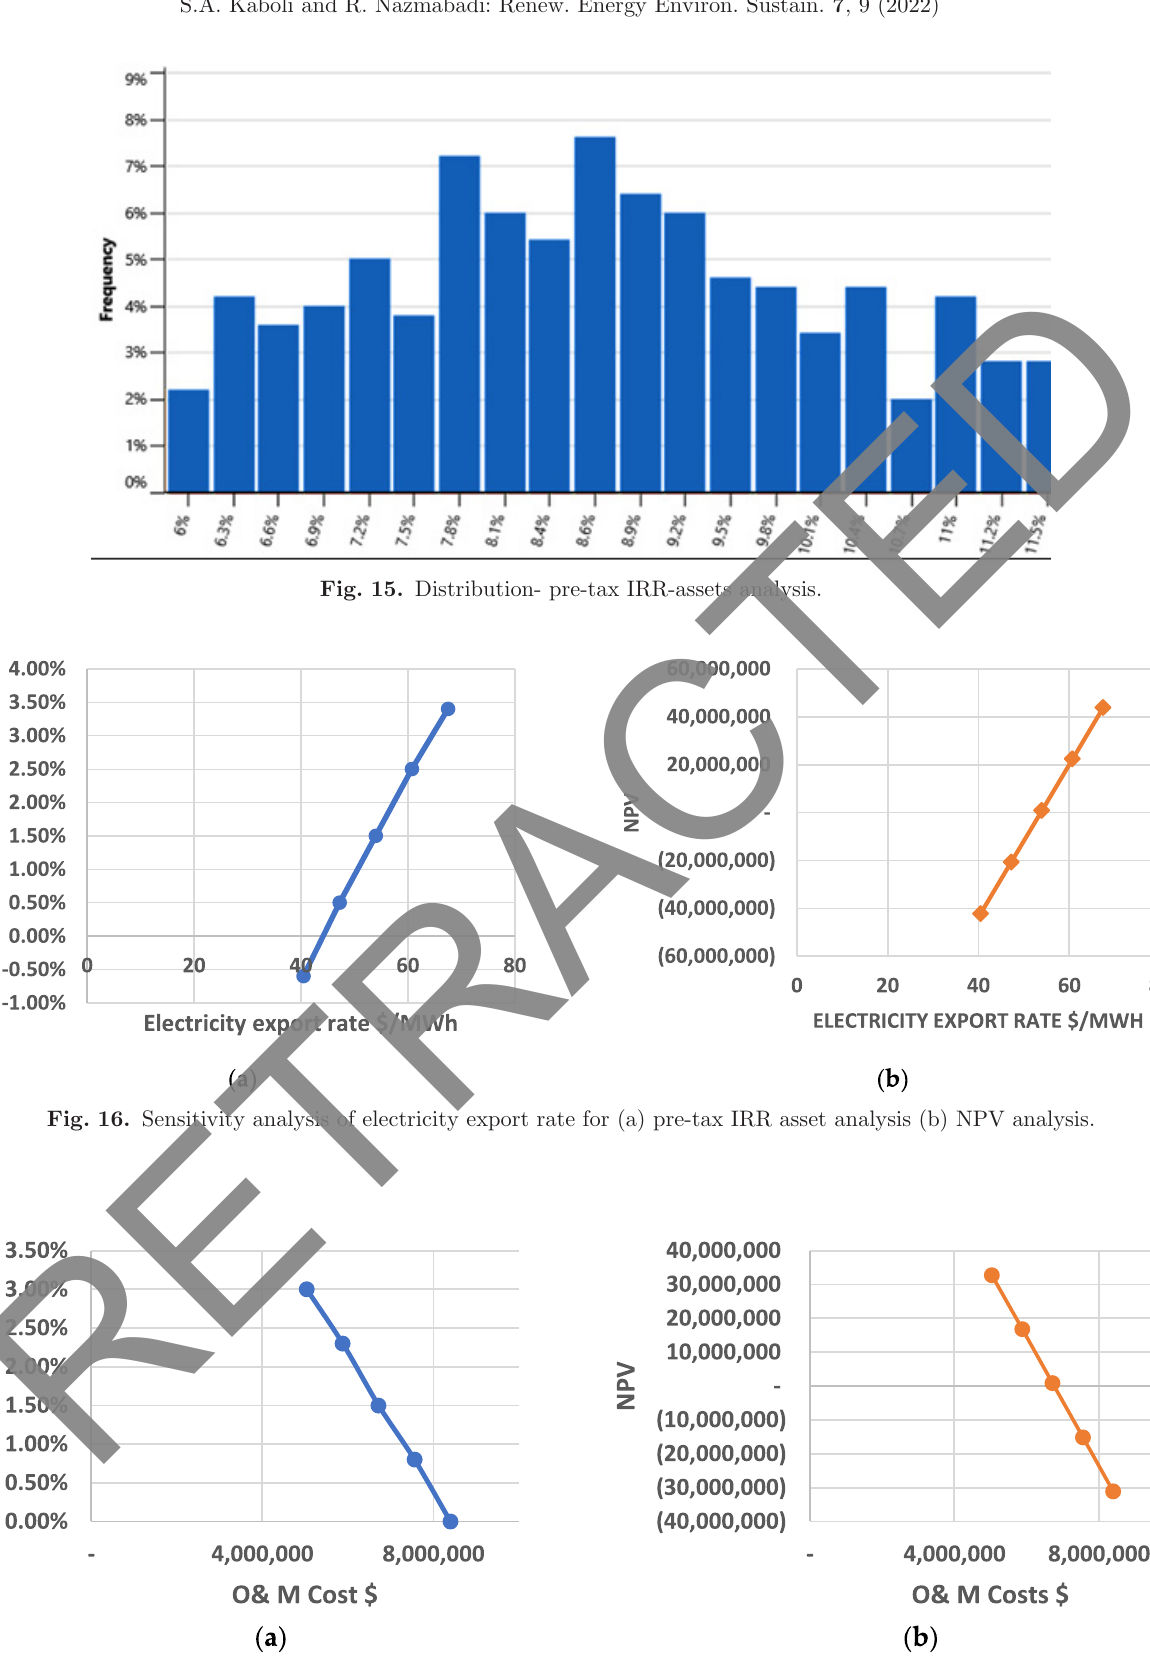
Fig. 17. Sensitivity analysis of O&M costs for (a) pre-tax IRR asset analysis (b) NPV